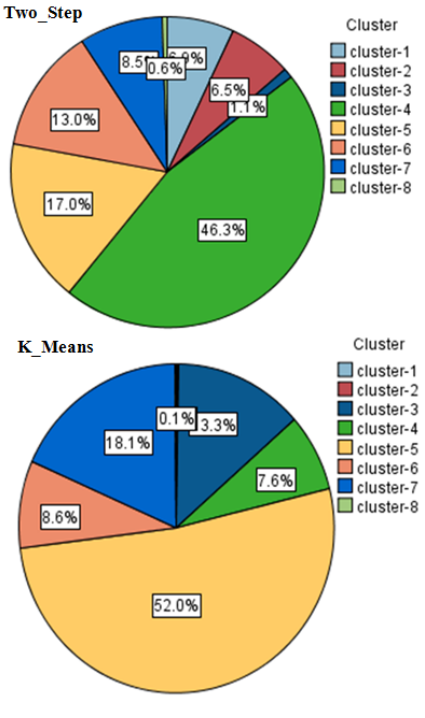
Figure 8: Two_Step and K_Means with 8 clusters.